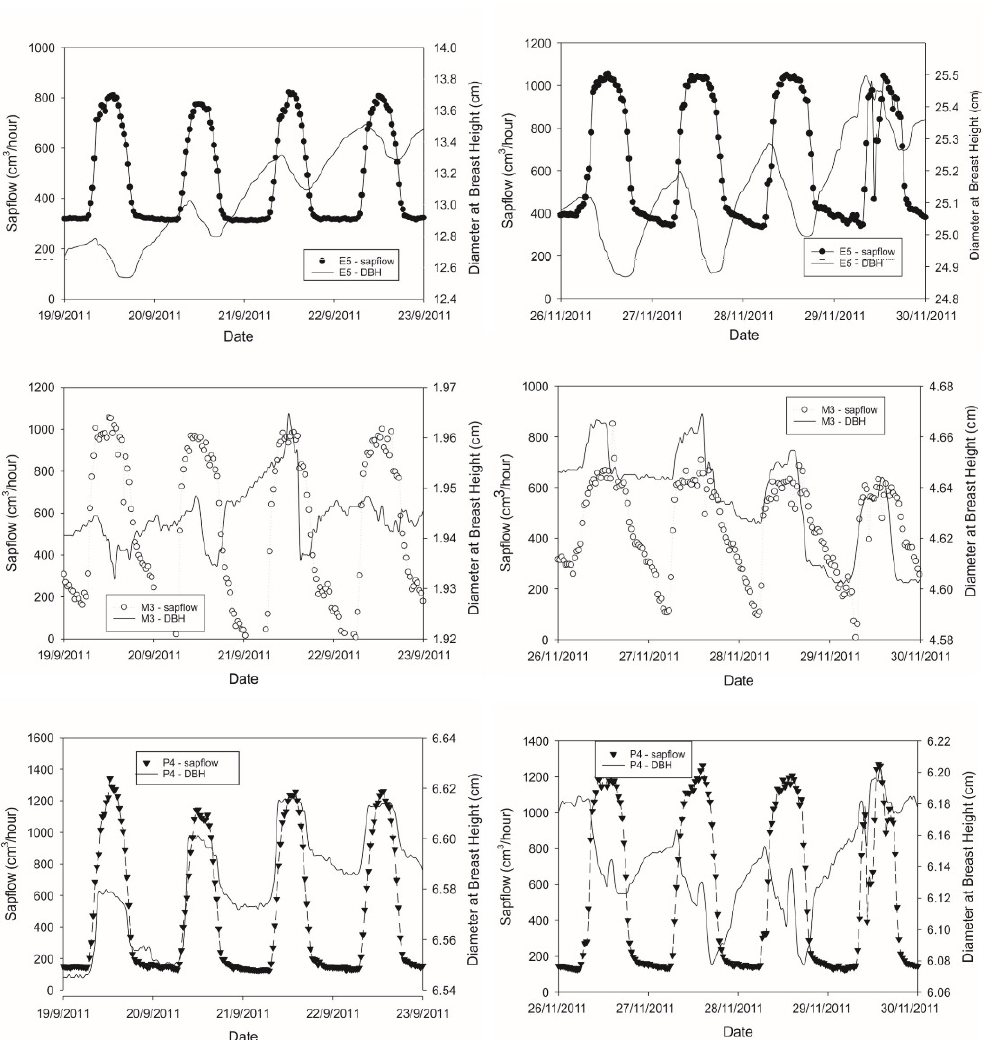
Figure 6. Diurnal variations in sap flow vs. DBH for 3 of the trees monitored, in September 2011 (left hand side) and November 2011 (right hand side).